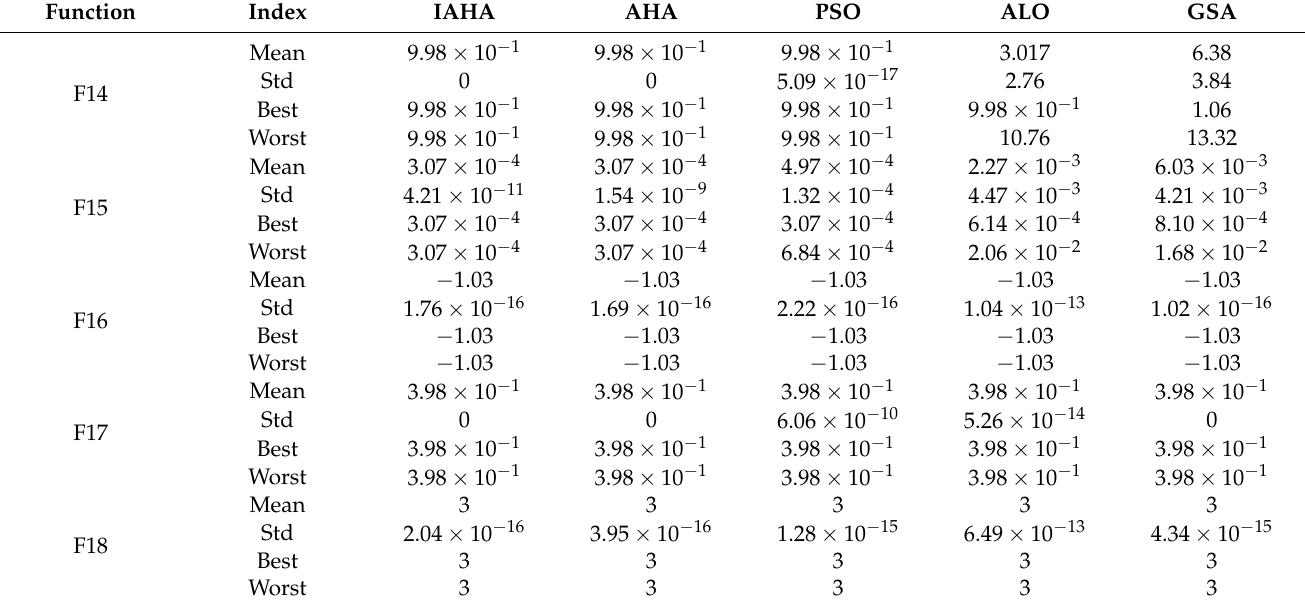
Table 4. Statistical results of low-dimensional multi-peak test functions of each